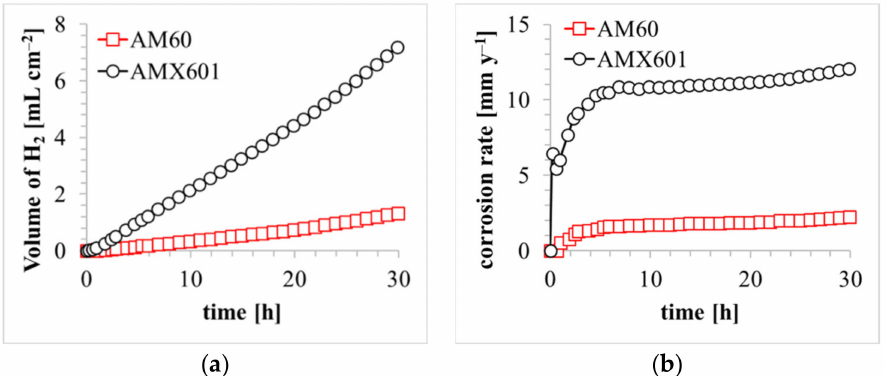
Figure 5. ( a ) Hydrogen evolution rate curve; ( b ) corrosion rate curves for AM60 and AMX601 alloys immersed in 3.5 wt% NaCl solution saturated with Mg (OH) 2 at room